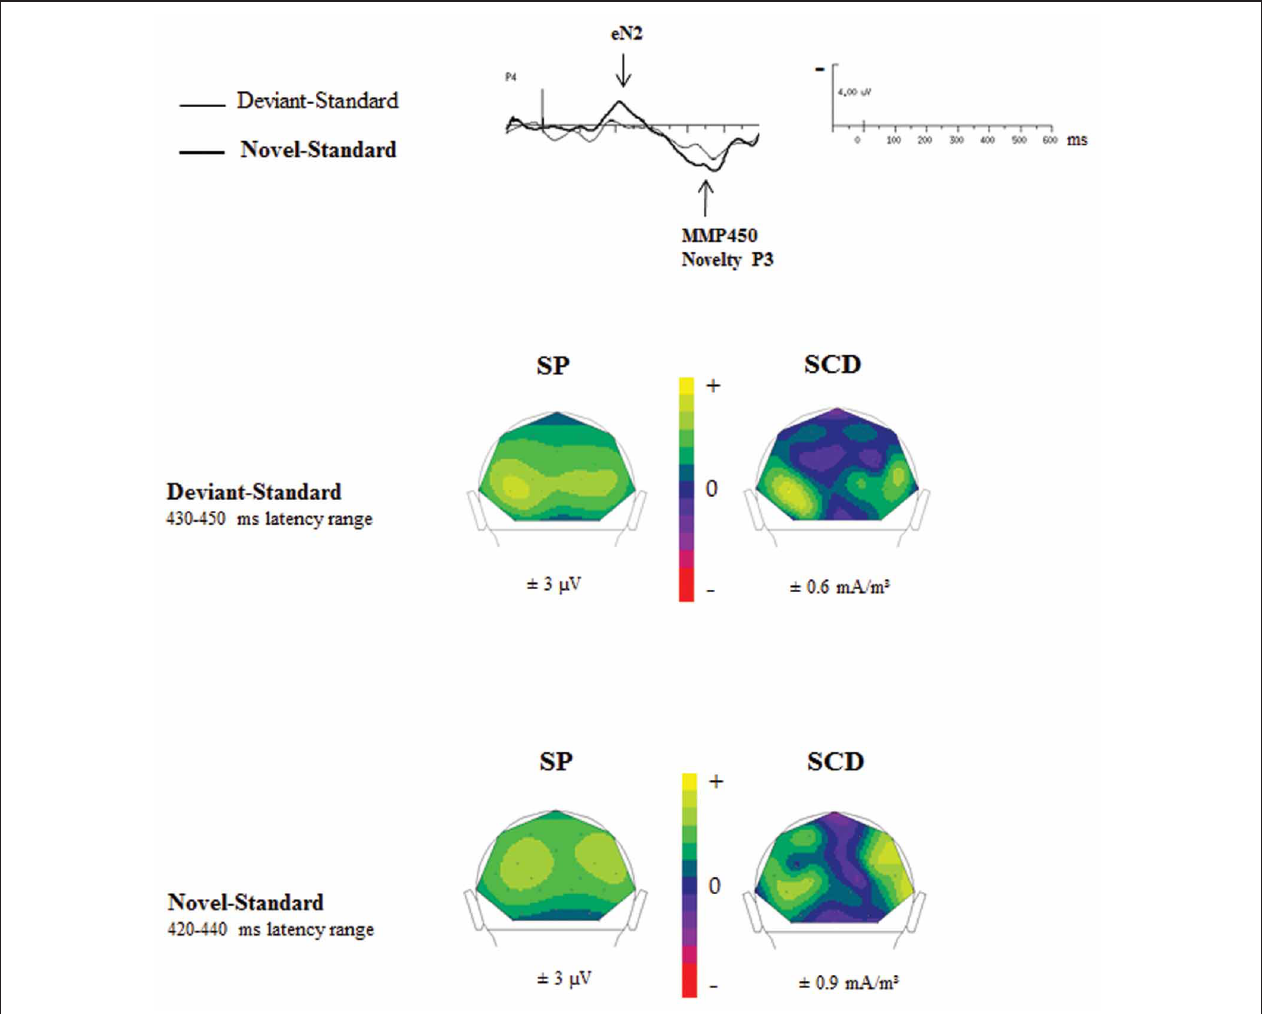
FIGURE 6 | Comparisons of the SP and SCD maps calculated in the MMP450 and the novelty P3 latency range in adults with